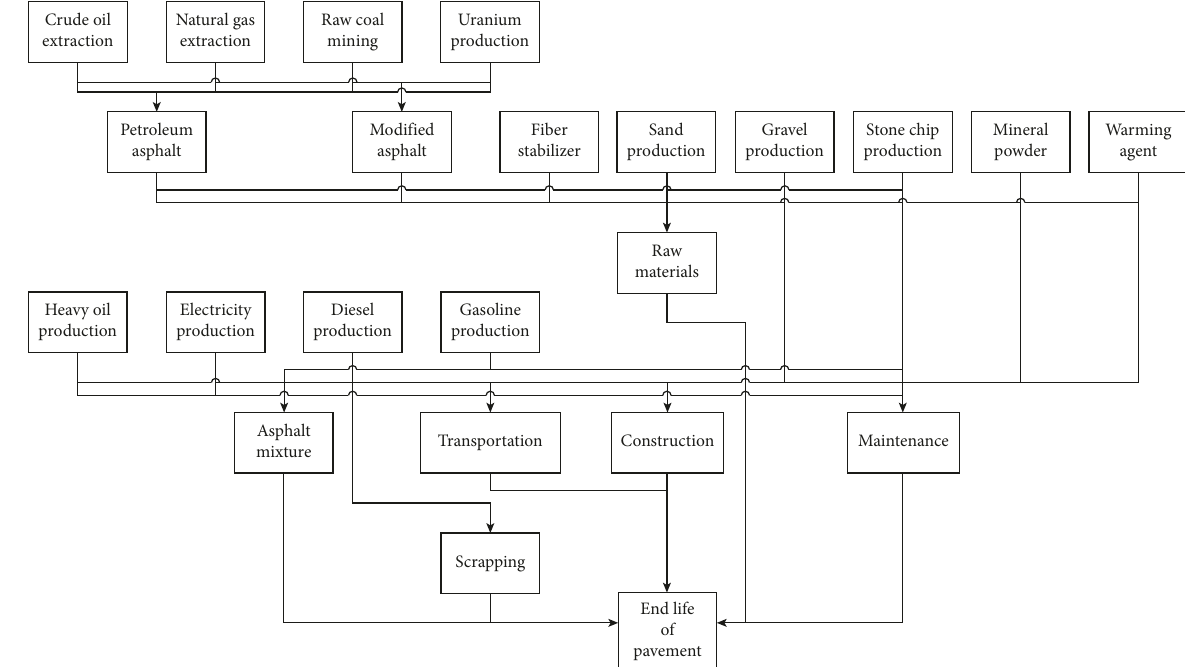
Figure 4: The LCA modeling process of WMA and HMA pavements in LCA-based